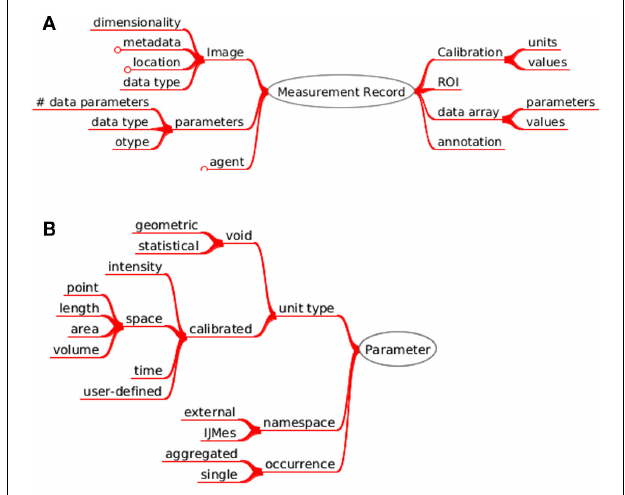
FIGURE 5 | Measurement data ontology. (A) The object references to the measured image and structured annotations. It contains the types of custom parameters, which were measured; the active region of interest, the array of produced numerical values and the calibration of the image that was measured. (B) Measured parameters are defined by unit type, name-space or